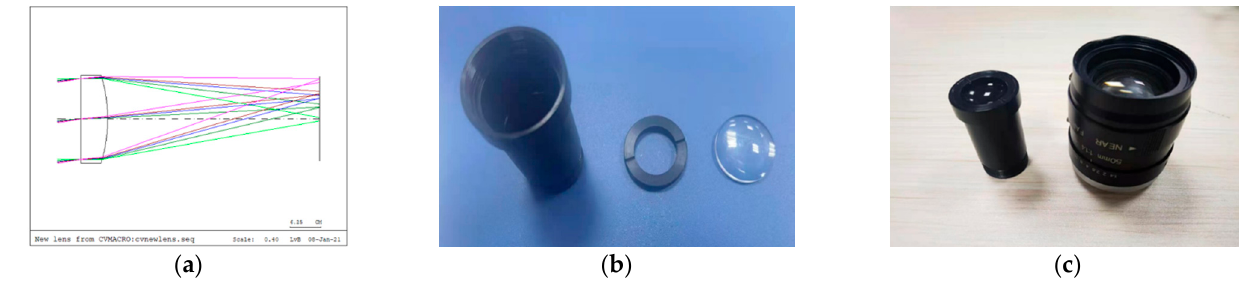
Figure 2. The procedure of self-made optical lens: ( a ) The light path of lens using CODE V software; ( b ) The components of self-made optical lens; ( c ) The assemble of self-made optical lens and its corresponding standard SLR lens.